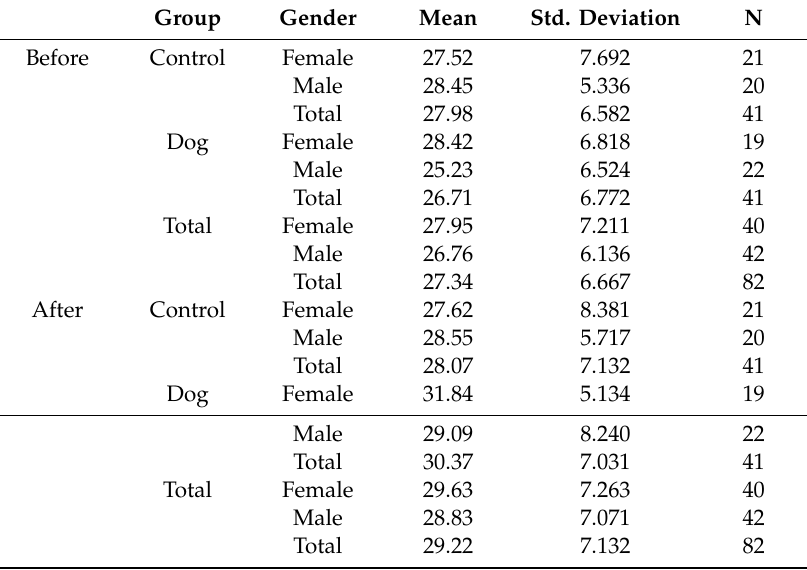
Table 9. Descriptive Statistics: Positive A ff ect and